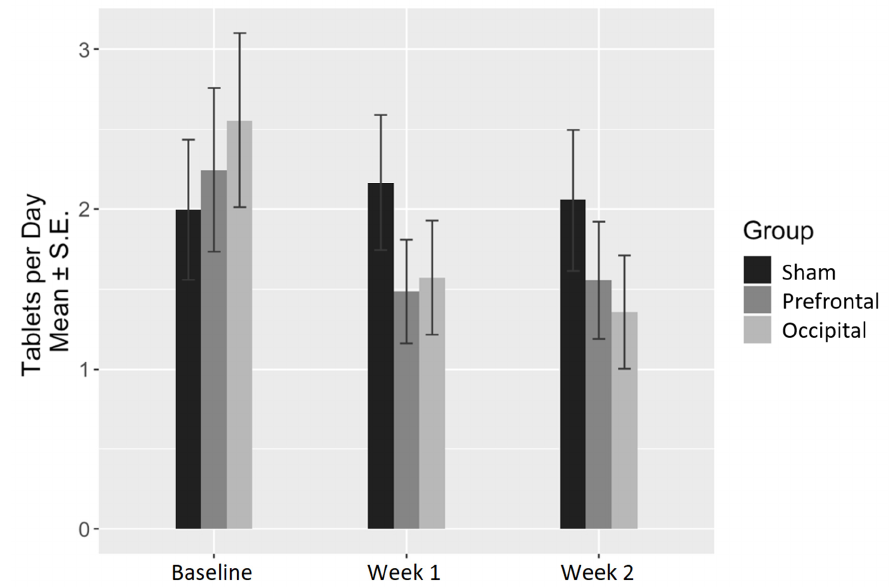
Figure 4. Change in the number of consumed pills per